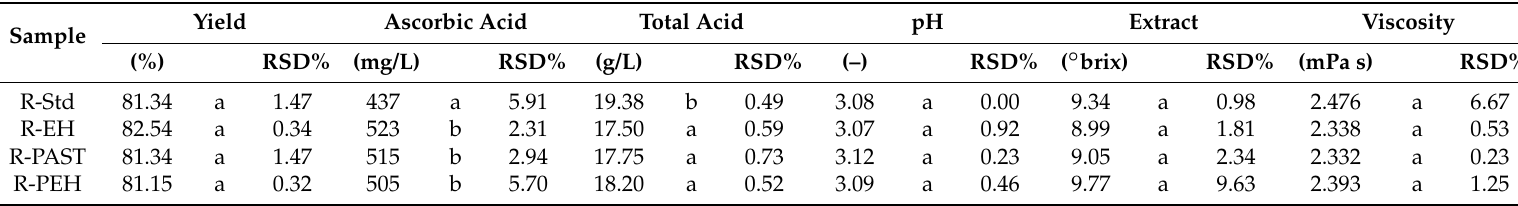
Table 1. Characteristic properties of red raspberry juices with different additions of stevia. Mean ± RSD %. Different letters in the same column indicate significant differences ( p < 0.05). R-Std: blank juice without stevia addition; R-EH: juice supplemented with 10% v / v of stevia crude water extract immediately before heat treatment; R-PAST: juice supplemented with 10% v / v of stevia crude water extract immediately before pasteurization; R-PEH: juice supplemented with 1% w / v of stevia dried leaf powder immediately before heat